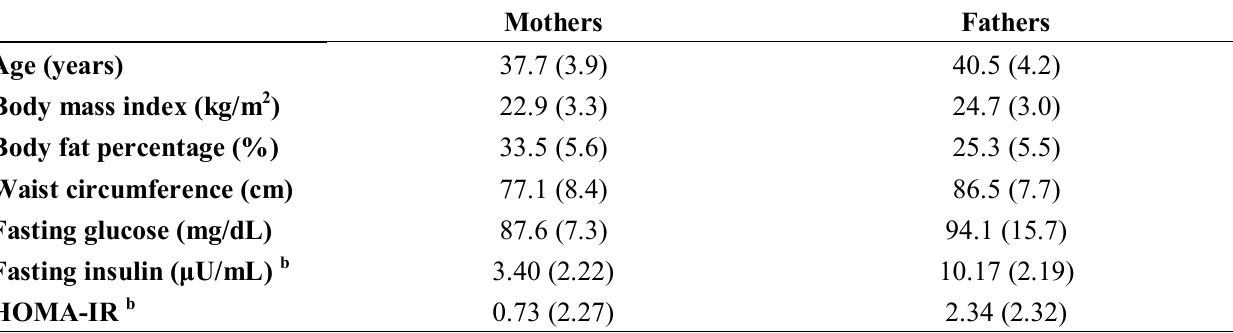
Table 2. General characteristics of parents. a